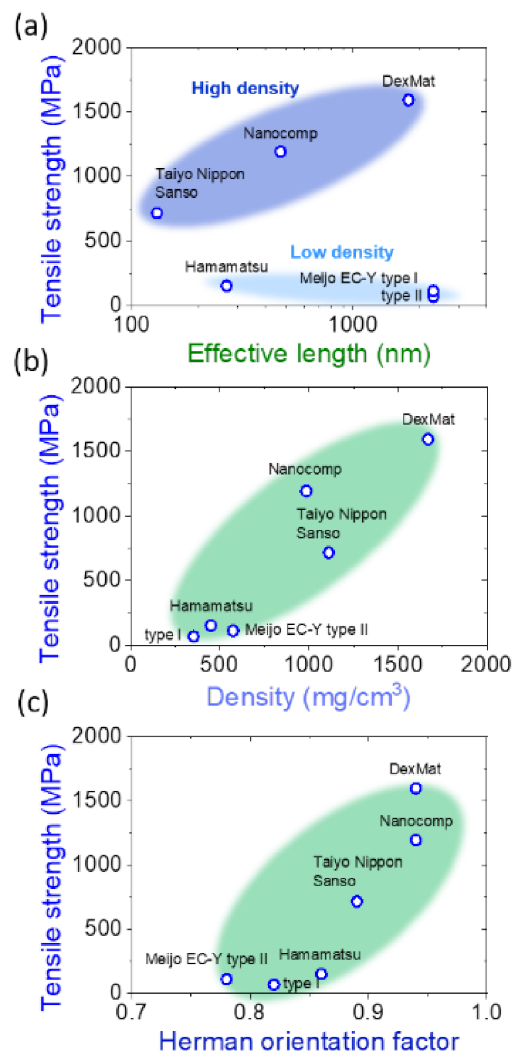
Figure 7. ( a ) Effective length, ( b ) density, and ( c ) Herman orientation factor dependences of the tensile strength of